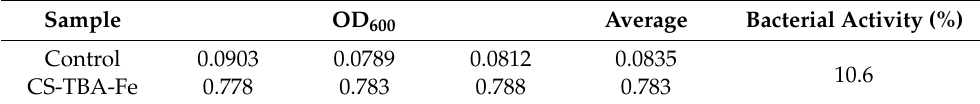
Table 2. Determination of the relative bacterial activity of E. coil .